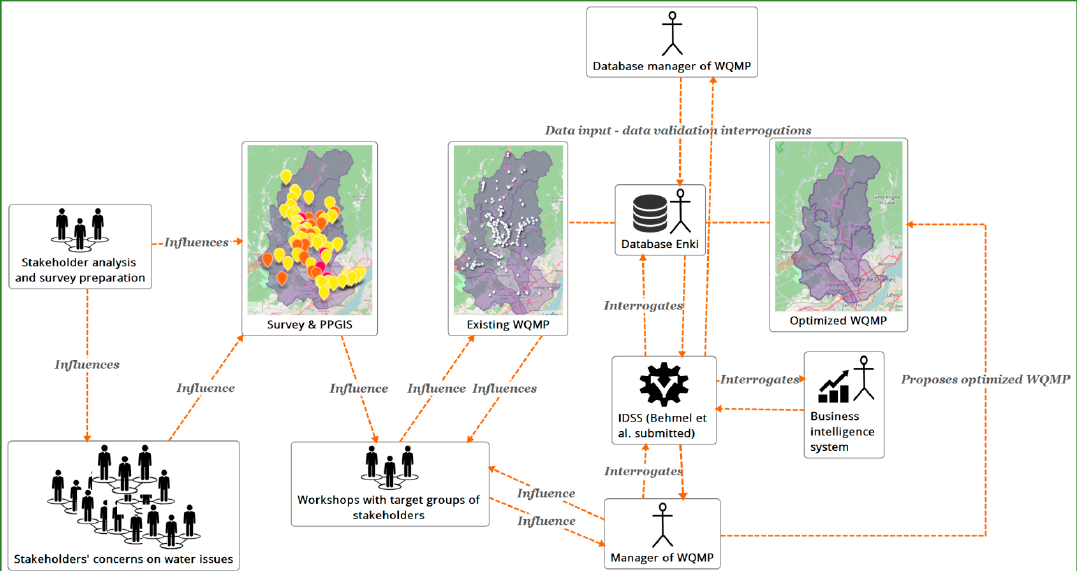
Figure 1. Global workflow of the optimization process of WQMPs. The purpose of the participative approach is to assess the attainment of past monitoring objectives and yield new monitoring objectives and optimization objectives. The results will influence the questions that the WQMP manager asks the IDSS to help the WQMP manager redesign the WQMP.